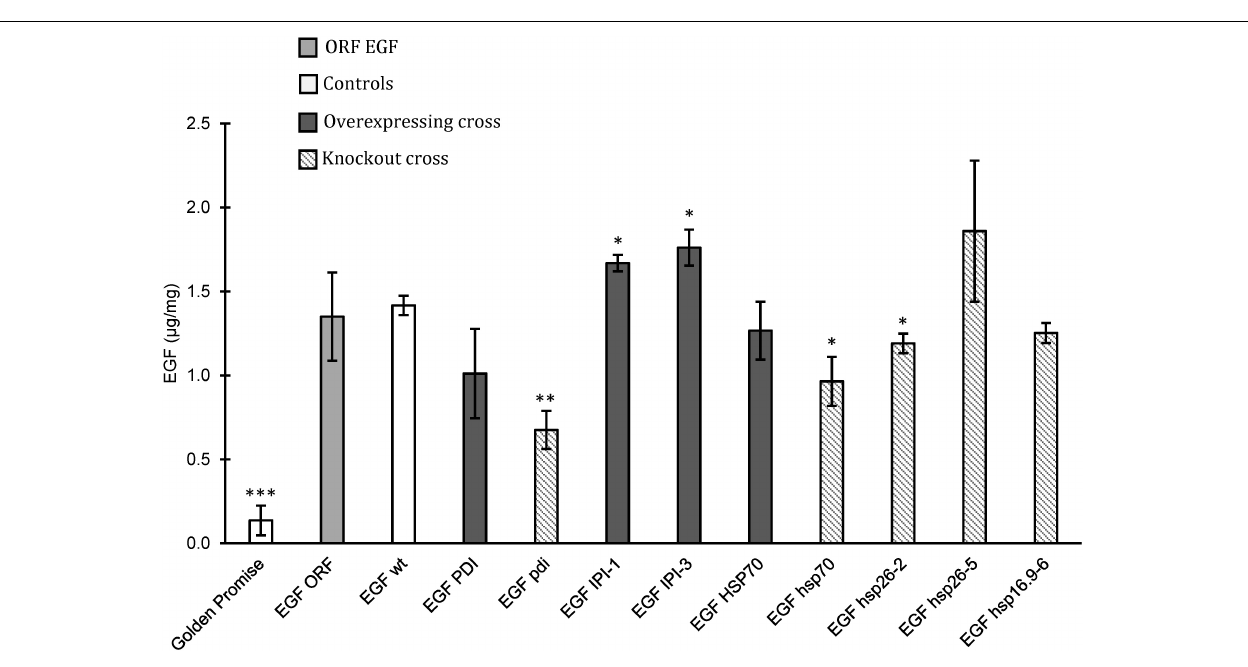
FIGURE 5 | Epidermal growth factor (EGF) concentration based on ELISA assay in mature grain flour. Golden Promise was used as a negative control. Controls (white), ORF EGF positive control (light gray) was grown in growth chamber and greenhouse. Crossed plants with overexpression (dark gray) and crossed plants with knockout mutation (diagonal). Error bars represents standard error. Significant changes found by Student’s t -test ( ∗ p < 0.05, ∗∗ p < 0.01, ∗∗∗ p <